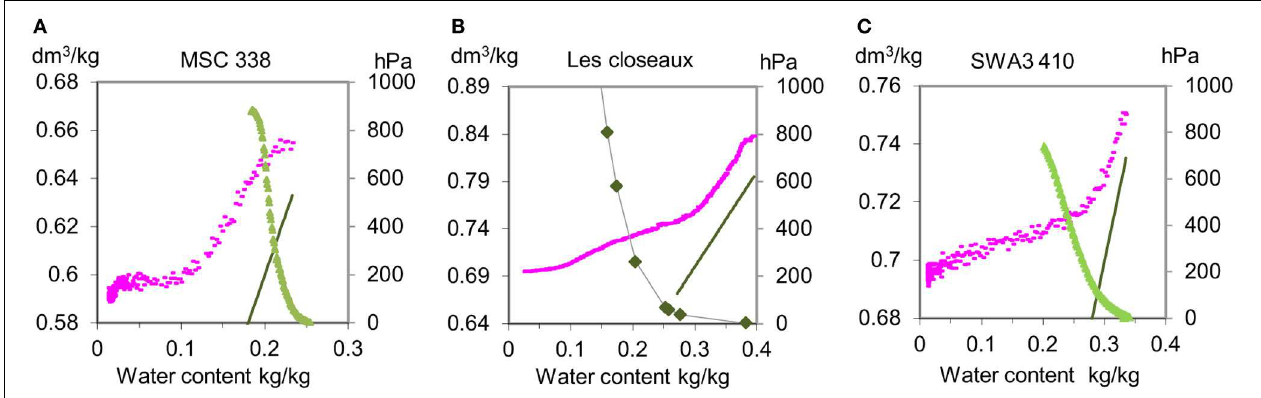
FIGURE 5 | Three types of shrinkage curves (A) sigmoidal; (B) sigmoidal with a saturating interpedal shrinkage phase; and (C) curvilinear structural shrinkage from Betsogo Atoua (2010), Salahat et al.